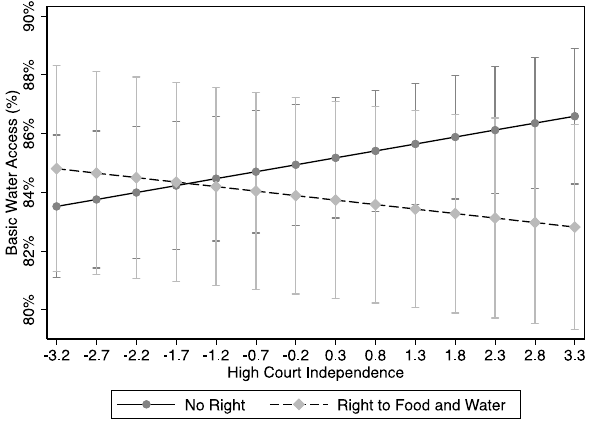
Figure 5. Marginal E ff ects of High Court Independence and Right to Food and Water on Access.